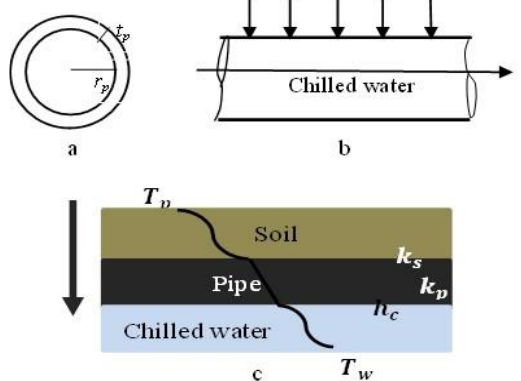
Figure 2: (a – c) Chilled water tube cross section and flow of heat across the sections